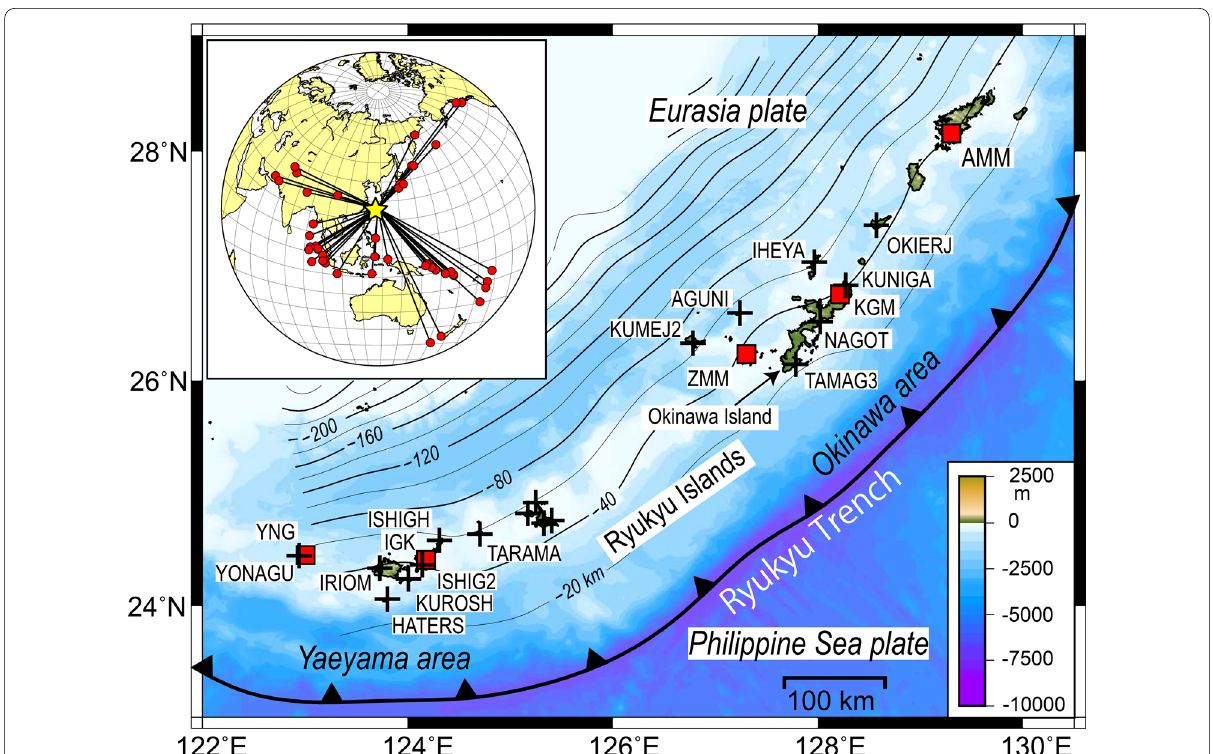
Fig. 1 Distribution of the seismic stations. Squares denote the F-net stations, and the crosses denote the JMA stations. Solid black contours show the depth of the plate interface (Hayers et al. 2012). The inset shows the distribution of the teleseismic earthquakes (red circles) used in this